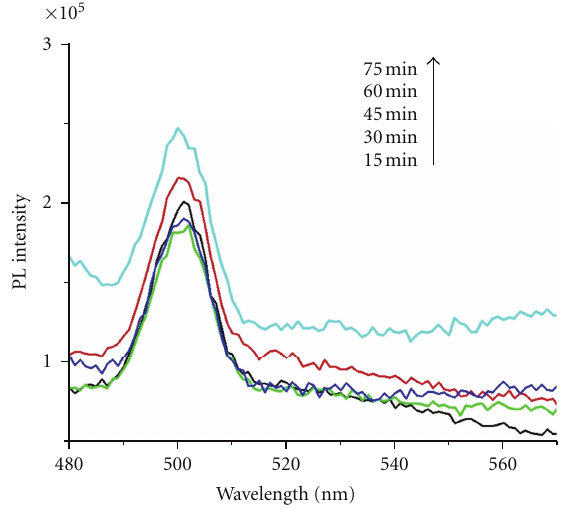
Figure 5: PL spectral changes with irradiation time on the undoped TiO 2 and 10 ppm coumarin.